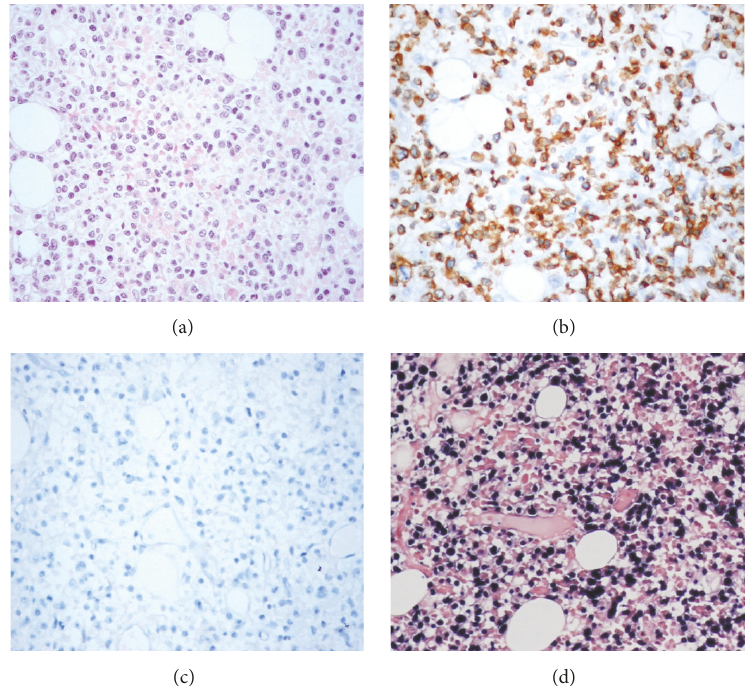
Figure4:Bonemarrowhistologicalfindings.BonemarrowbiopsysectionWright-Giemsastained(40x)(a).Thelymphoidinfiltrateispositive for CD3 epsilon (b) and negative for CD56 (c). In situ hybridization showing positivity of the neoplastic cells for EBER (d).